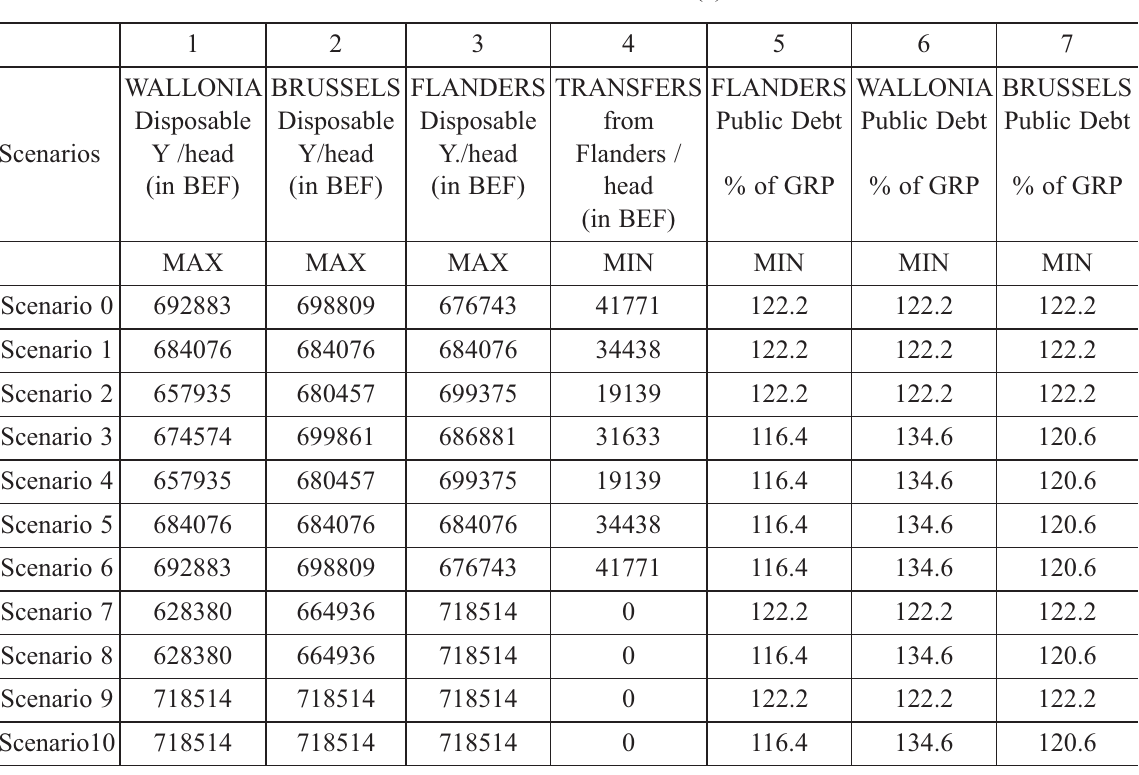
Table 3. Matrix of Responses of Scenarios on Objectives for the Belgian Regions at the Maastricht moment